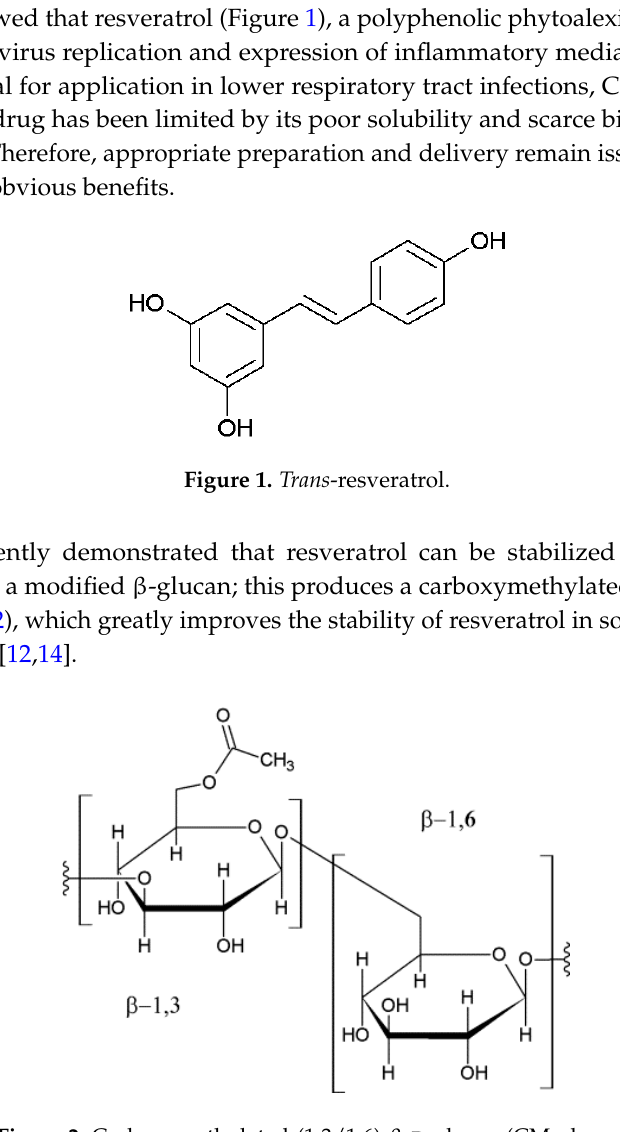
Figure 2. Carboxymethylated-(1,3/1,6)- β - D -glucan (CM-glucan).